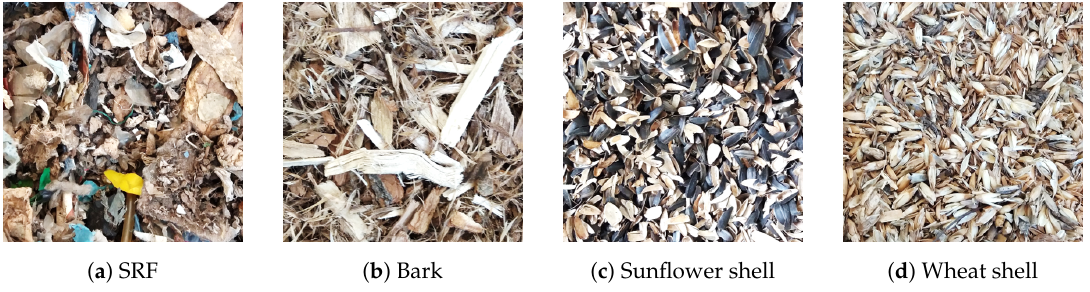
Figure 1. Photographic view of the active particles used in the present study. (The original horizontal length of each photo is 7 cm). Table 2. Chemical characteristics of the active particles used in the present